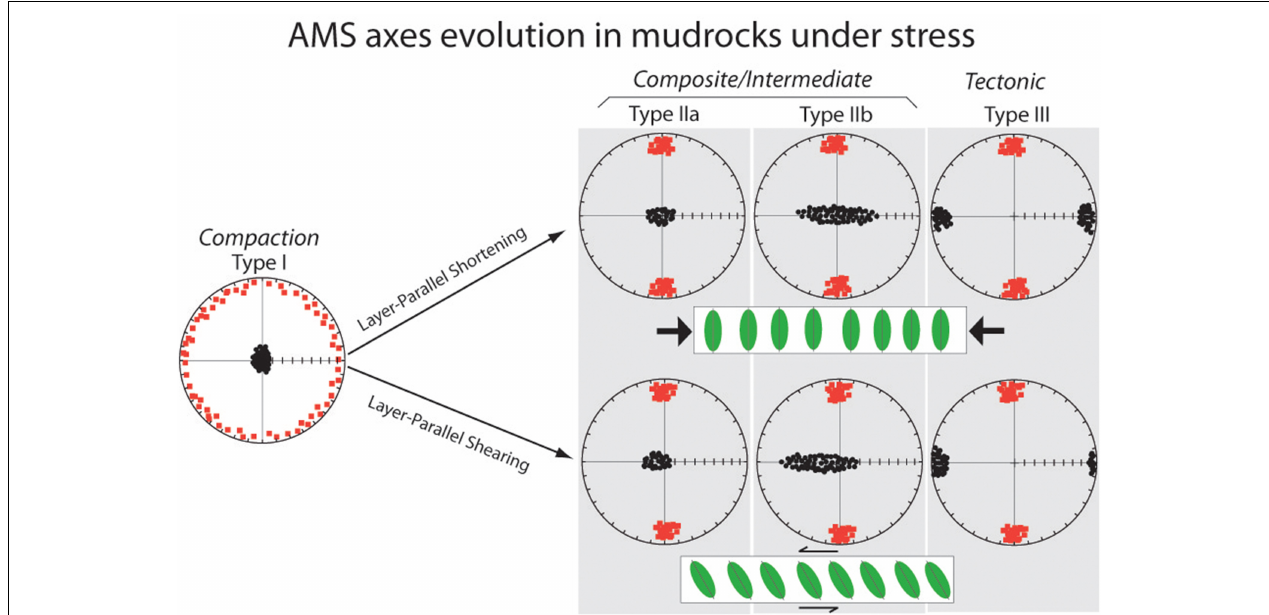
parallel the intersection direction between these two planes. K min axes eventually show a girdle that is parallel to the maximum shortening direction. Ultimately K min axes become parallel to the shortening direction and K max axes remain parallel to the intersection direction and not necessarily to the maximum extension direction. Rocks deformed by layer-parallel shearing, Types IIa and IIb ellipsoids show a girdle of K min axes that are plunging away from the tectonic extension